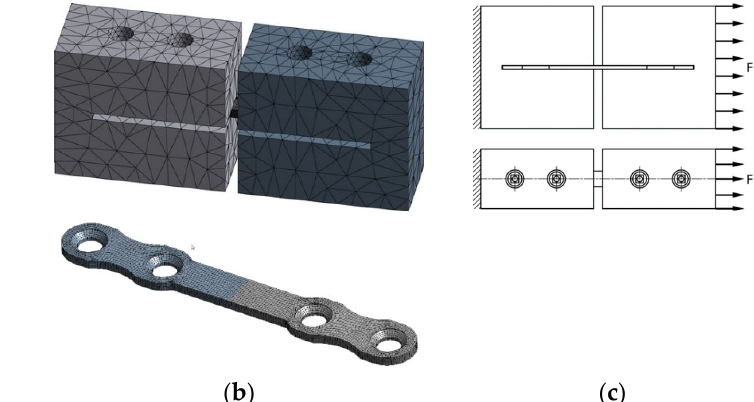
Figure 1. Solid ( a ) and mesh ( b ) models of a plate with bone fragments, and the respective loading principle ( c ).